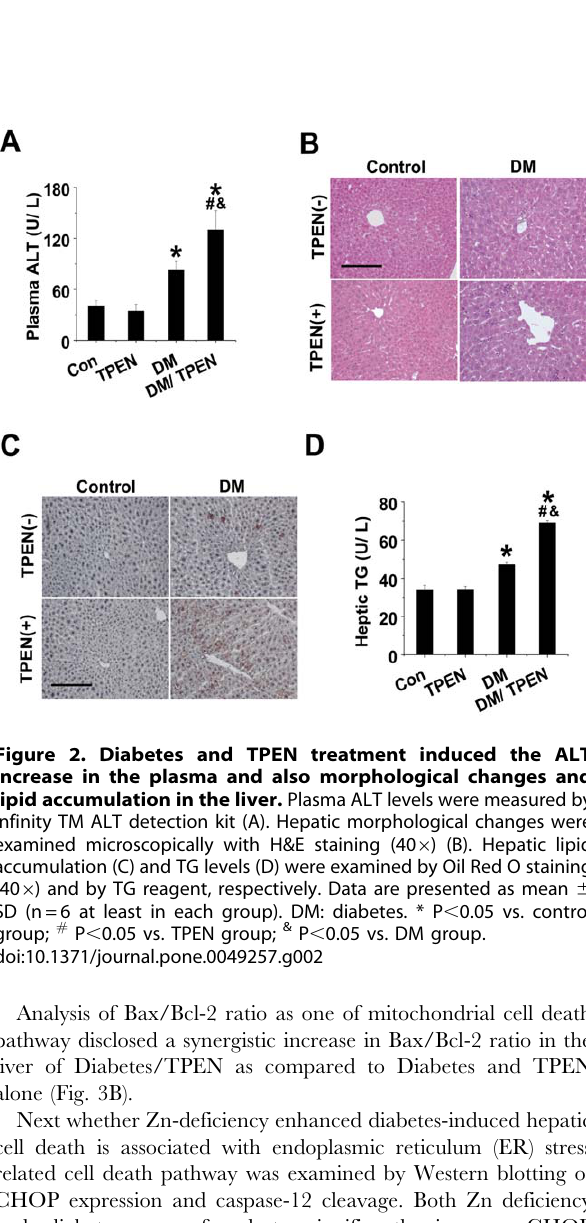
3-NT expression in both TPEN treatment and diabetes groups.